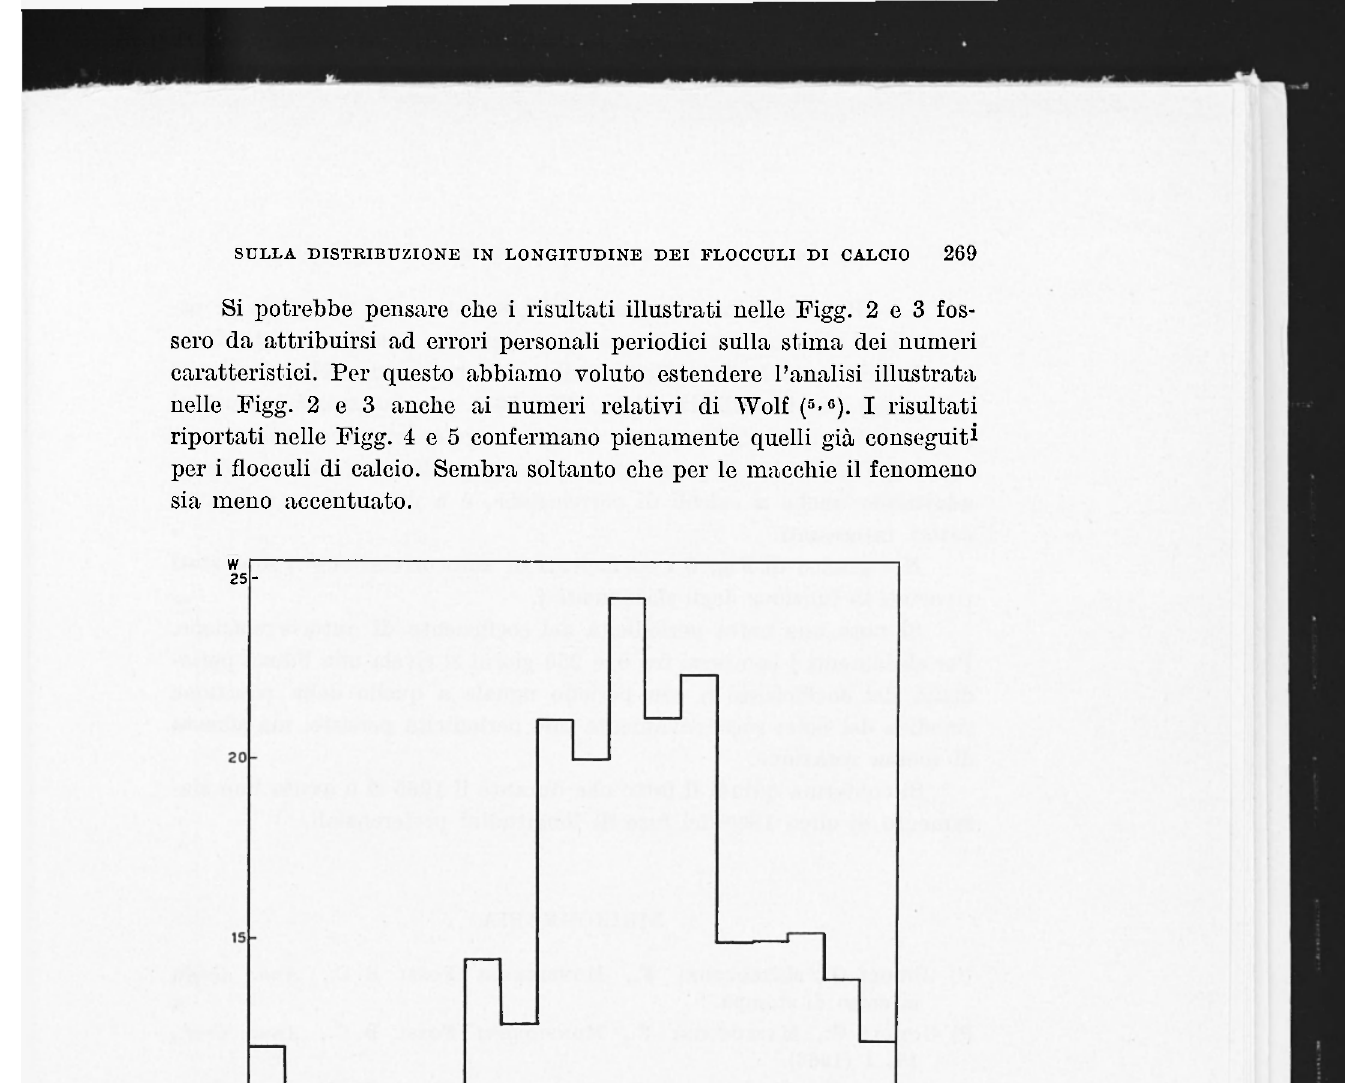
Fig. 5 - Distribuzione in elassi di 20° di longitudine delle medie dei numeri relativi di Wolf per l'anno